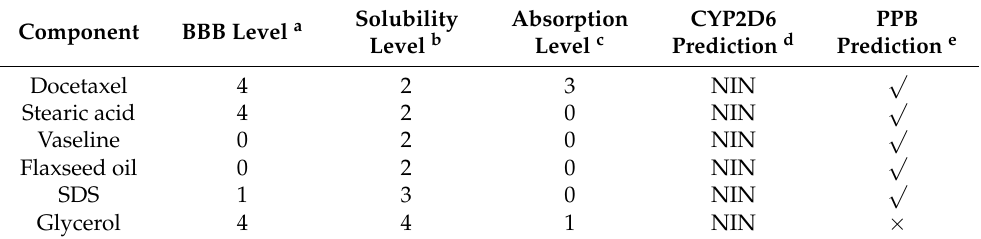
Table 2. ADME results of docetaxel and excipients.